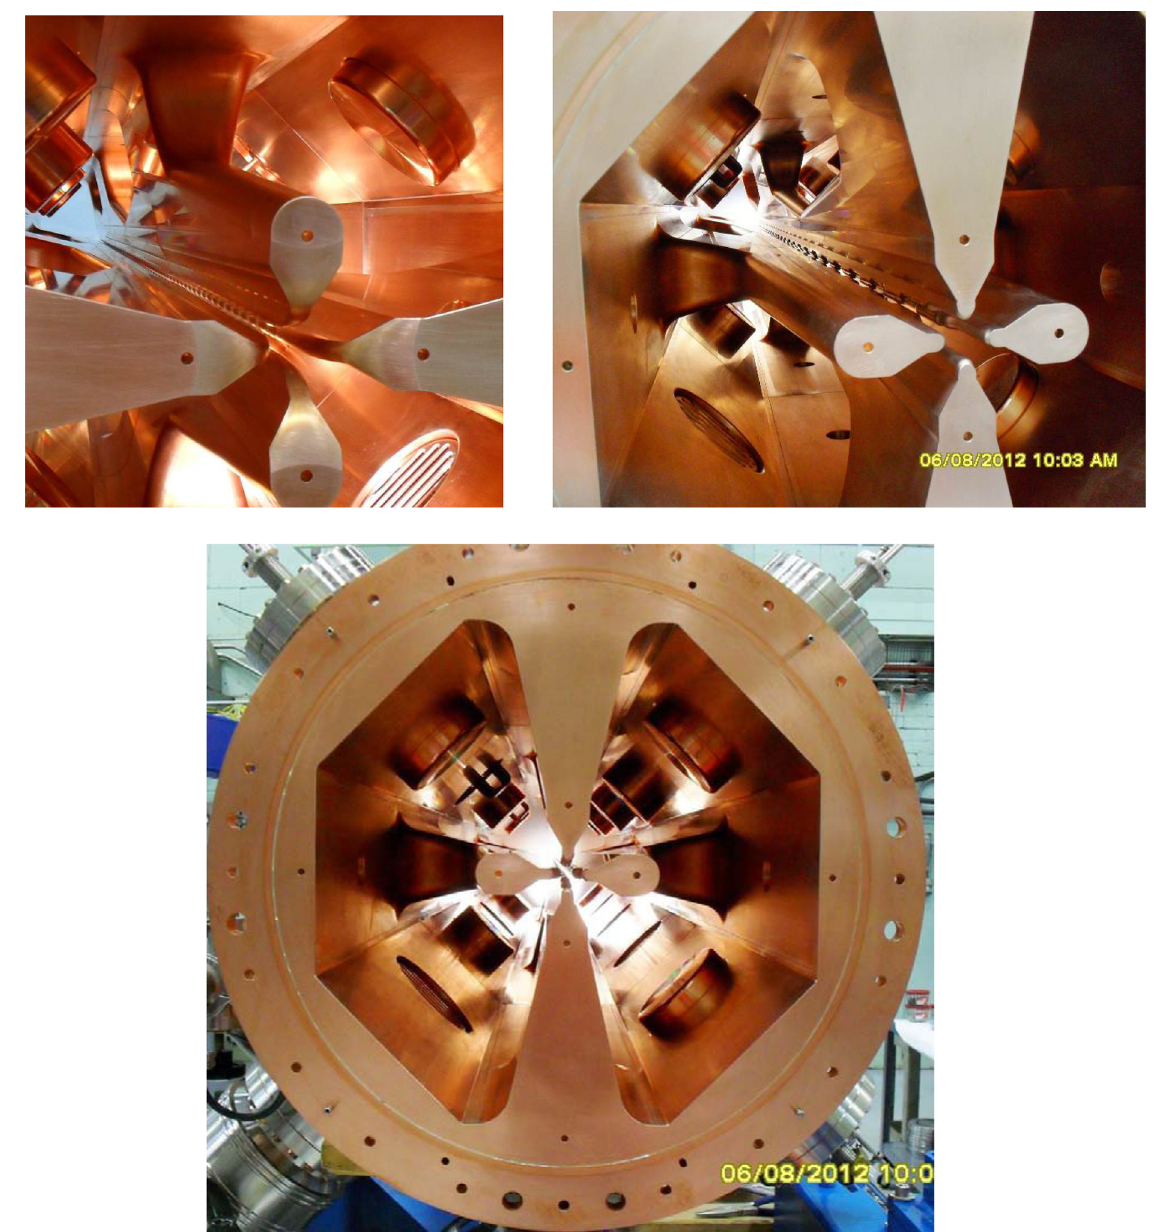
FIG. 12. Internal views of the RFQ after completed assembly. View from the low-energy end (top left) and high-energy end (top right and